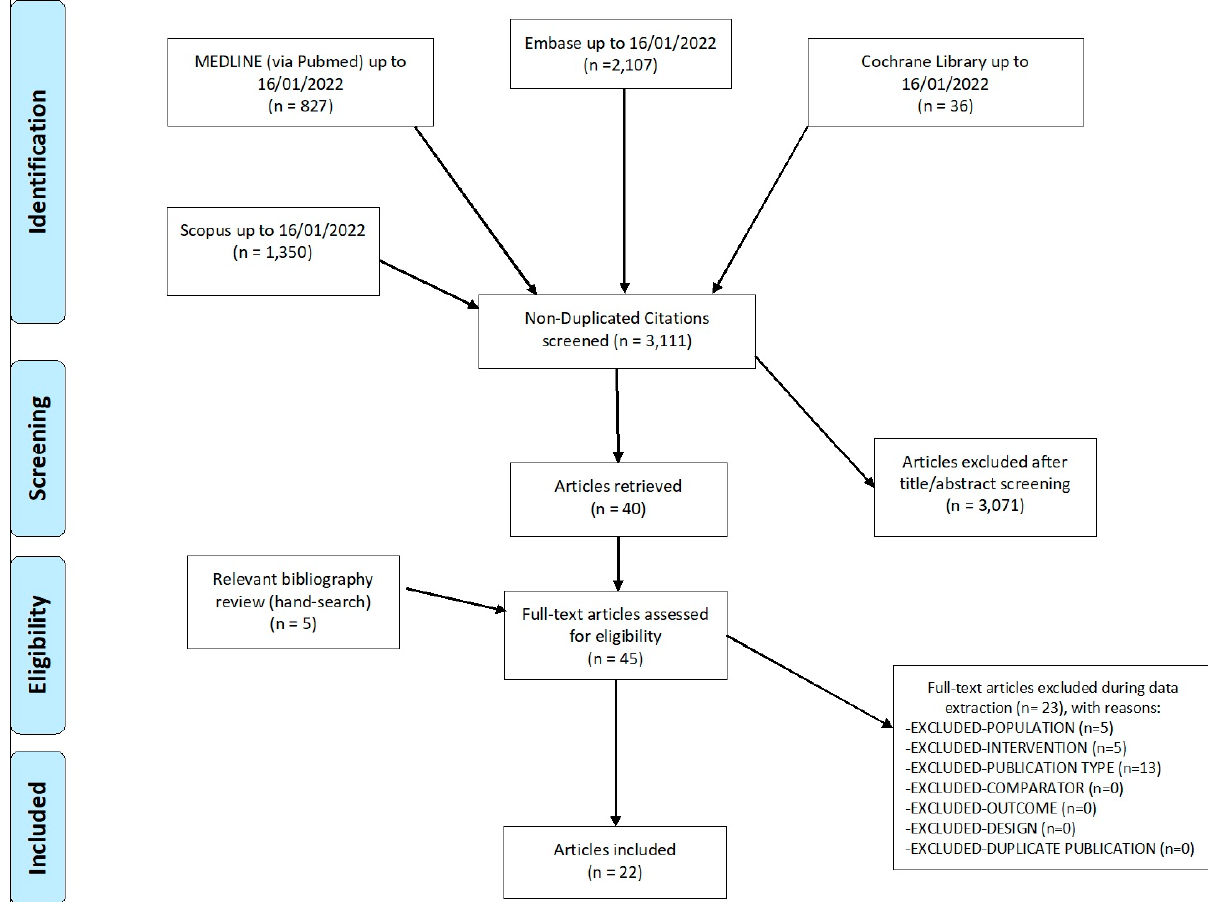
Figure 1. PRISMA Flowchart. Abbreviations: PRISMA: Preferred Reporting Items for Systematic Reviews and